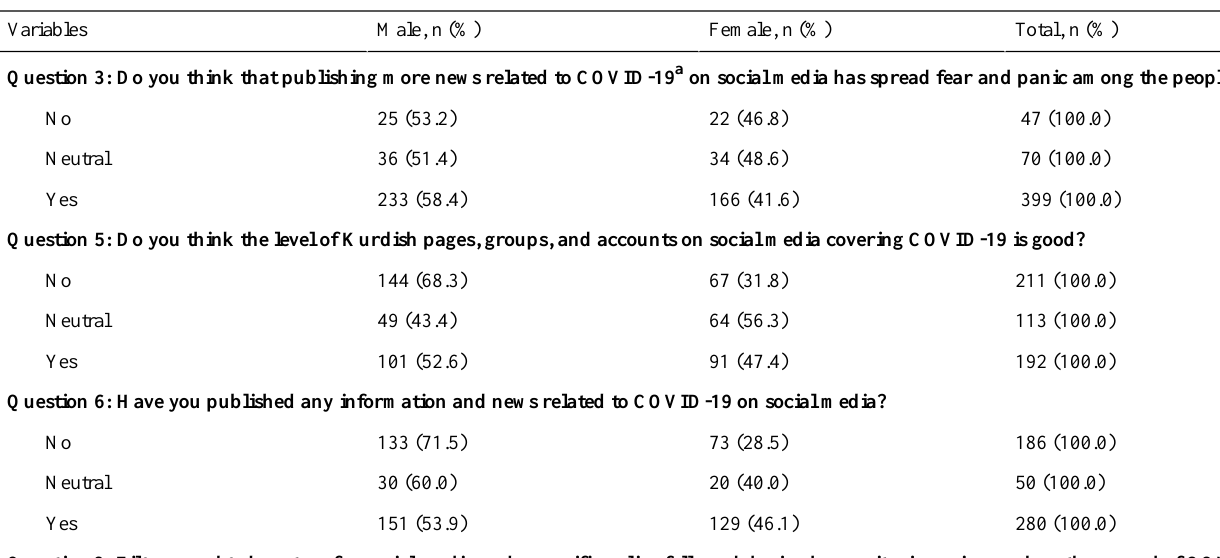
Table 7. Some questions according to the gender of participants